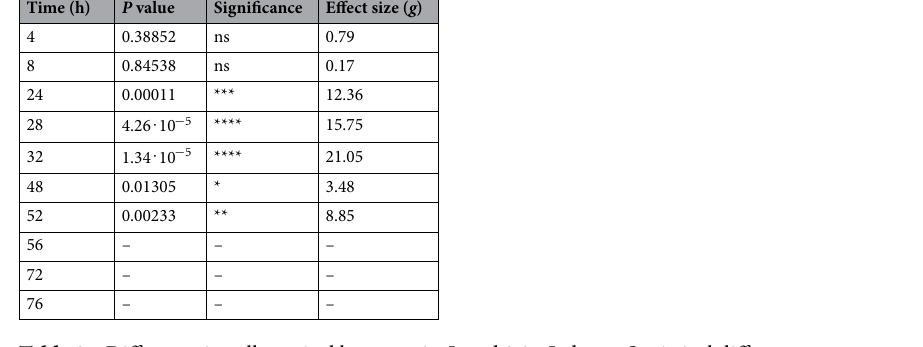
Table 2. Difference in cell survival between 2 nL and 0.2 nL drops. Statistical differences are presented as P values. Two-sided Student’s t test was used to find significance values. Effect sizes were calculated as Hedges’